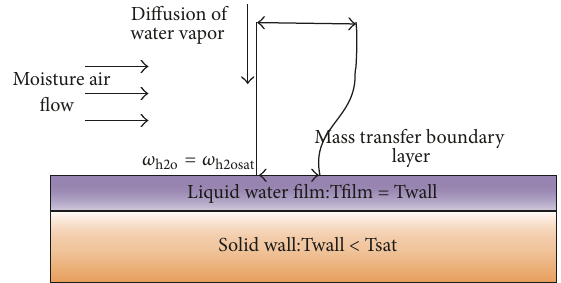
Figure 3: Schematic of the condensation model [3].